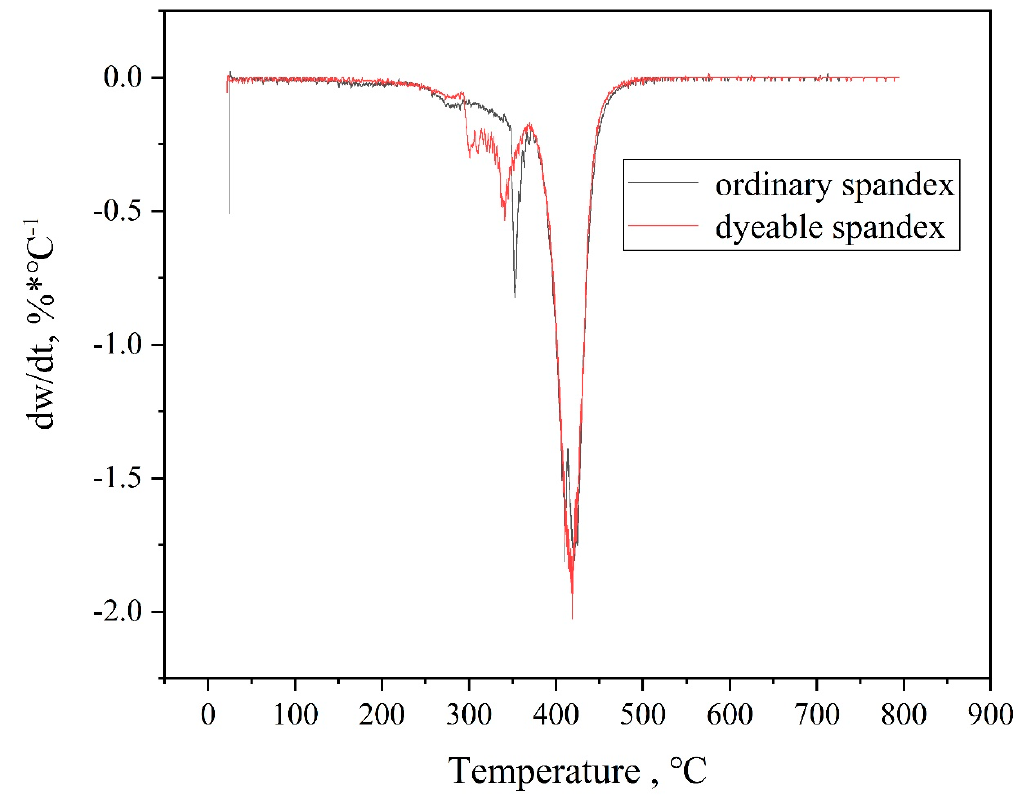
Figure 4. DTG curves of dyeable spandex and ordinary spandex.